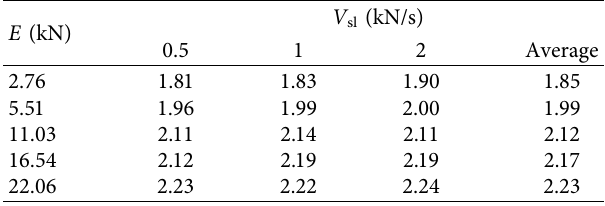
Table 3: Fractal dimensions of particle size under different maximum loads and loading speeds.